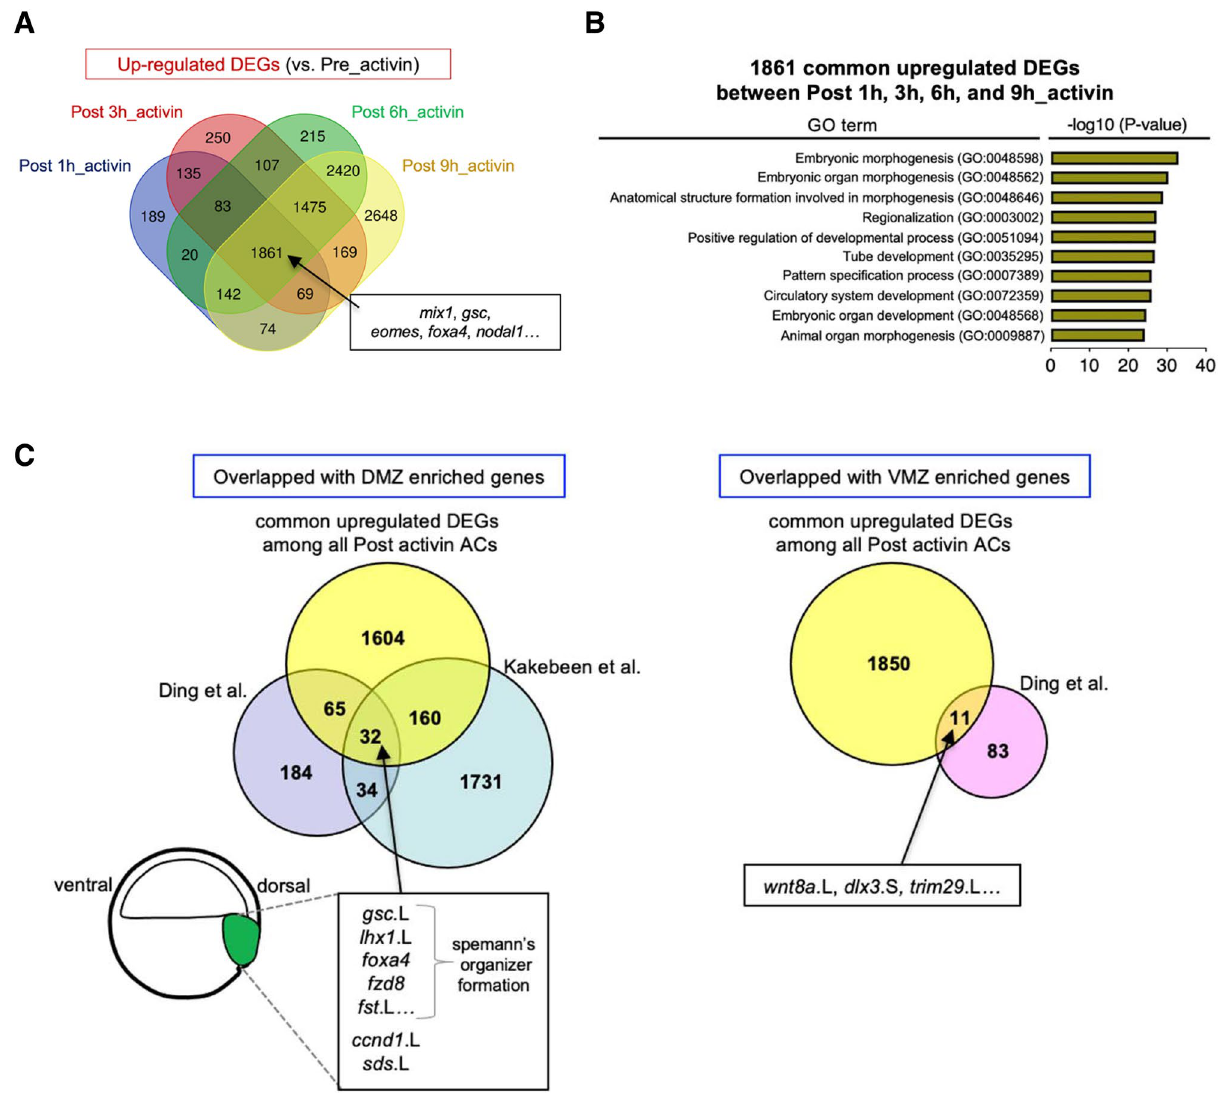
Figure 3. Common upregulated DEGs among Post_activin samples. ( A ) Venn diagrams showing overlap among upregulated DEGs. The numbers of common and unique upregulated DEGs are displayed in colored ellipses. Known activin responsive genes are listed as indicated. ( B ) Gene ontology (GO) enrichment analysis of 1861 common upregulated DEGs between Post 1 h, 3 h, 6 h, and 9h_activin. The top ten enriched GO terms in biological processes, and the -log10 (P-value) of the significant GO terms are displayed in order of significance from the bottom of the list. ( C ) Left Venn diagram showing the comparison of DMZ-enriched genes at stage 10.5 (Ding et al.), those at stage 11 (Kakebeen et al.) and common upregulated DEGs among all Post_activin samples. The representatives of overlapping genes among three studies are indicated. Right Venn diagram showing the comparison of VMZ-enriched genes at stage 10.5 (Ding et al.) and common upregulated DEGs among all Post_activin samples. The numbers of common and unique genes in independent studies are displayed in colored